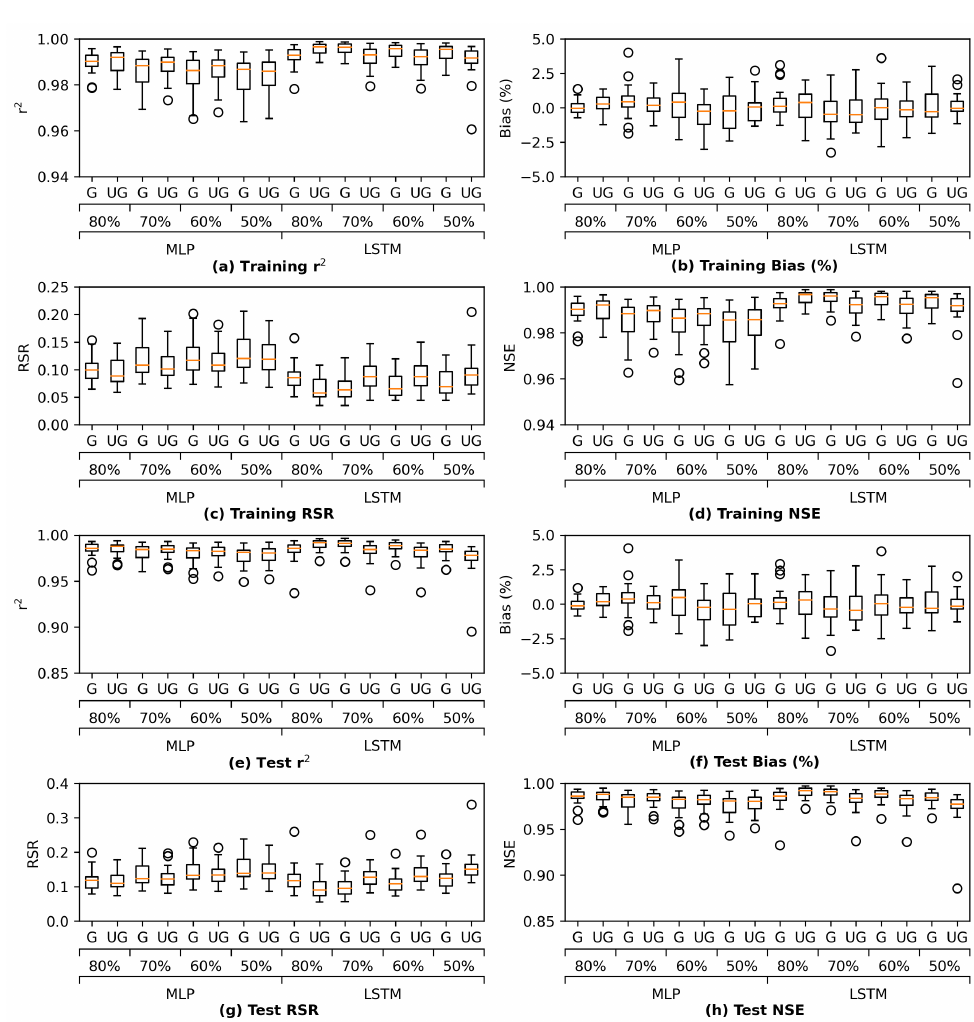
Figure 8. Box and whisker plots of four types of metrics consisting of r 2 , percent bias, RSR, and NSE during the training (panels ( a – d )) and test (panels ( e – h )) phases of the grouped (G) as well as ungrouped (UG) MLP and LSTM models under four scenarios with varying lengths of training data: 50%, 60%, 70%, and 80% of all the data